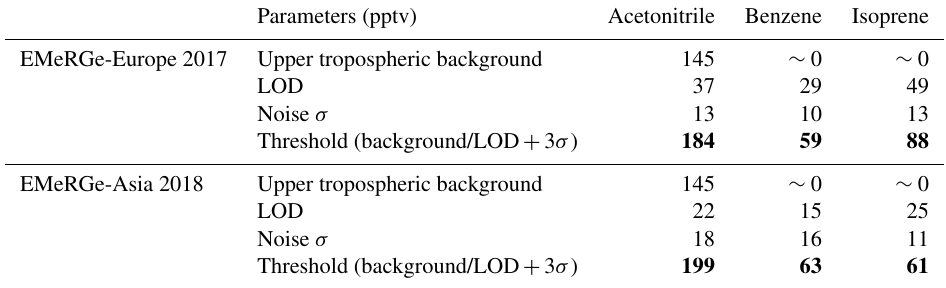
Table 2. Upper tropospheric background levels of acetonitrile, benzene, isoprene (determined for ∼ 11km), limit of detection (LOD) and observational noise σ used for inferring threshold levels to identify source signatures during EMeRGe-Europe and EMeRGe-Asia. Thresh- old limits are determined differently: background + 3 σ for acetonitrile and LOD + 3 σ for benzene and isoprene. Due to slightly changed sensitivities and instrumental backgrounds between 2017 and 2018, the LOD (depending on both) changed as well.